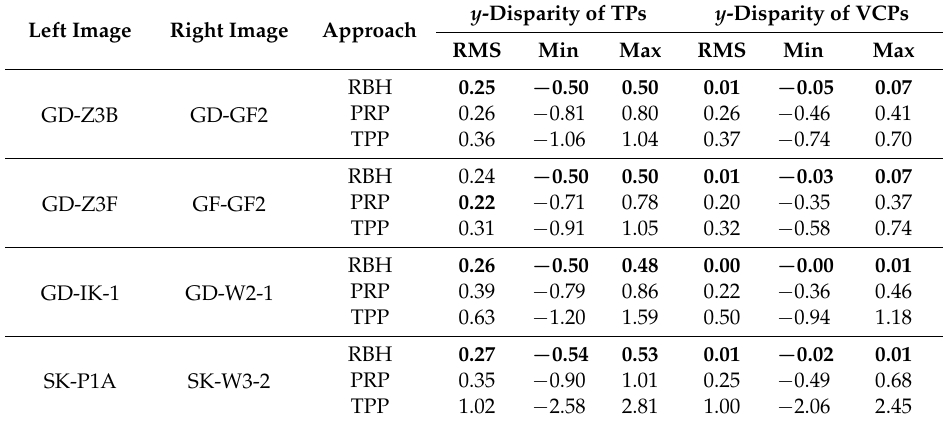
Table 4. The results of the image pairs in the cross-track non-coplanar stereo condition. y -Disparity of TPs y -Disparity of VCPs Left Image Right Image Approach